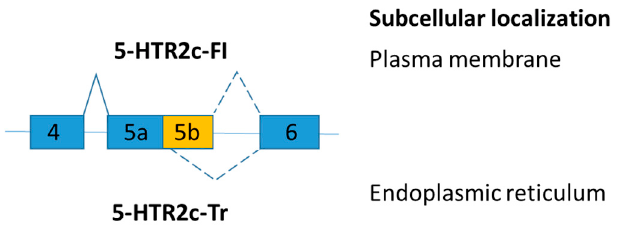
Figure 7. Schematic figure representing serotonin 2C receptor splice variants. The splice variants have very different subcellular distribution.